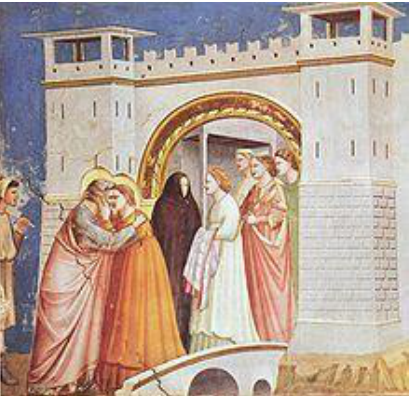
Fig. Joachim and Anne’s meeting (Giotto, Scrovegni Chapel, Padua, 1303-1305)